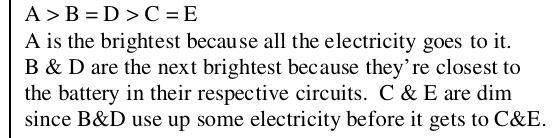
FIG. 4. Future teacher response modeling student response